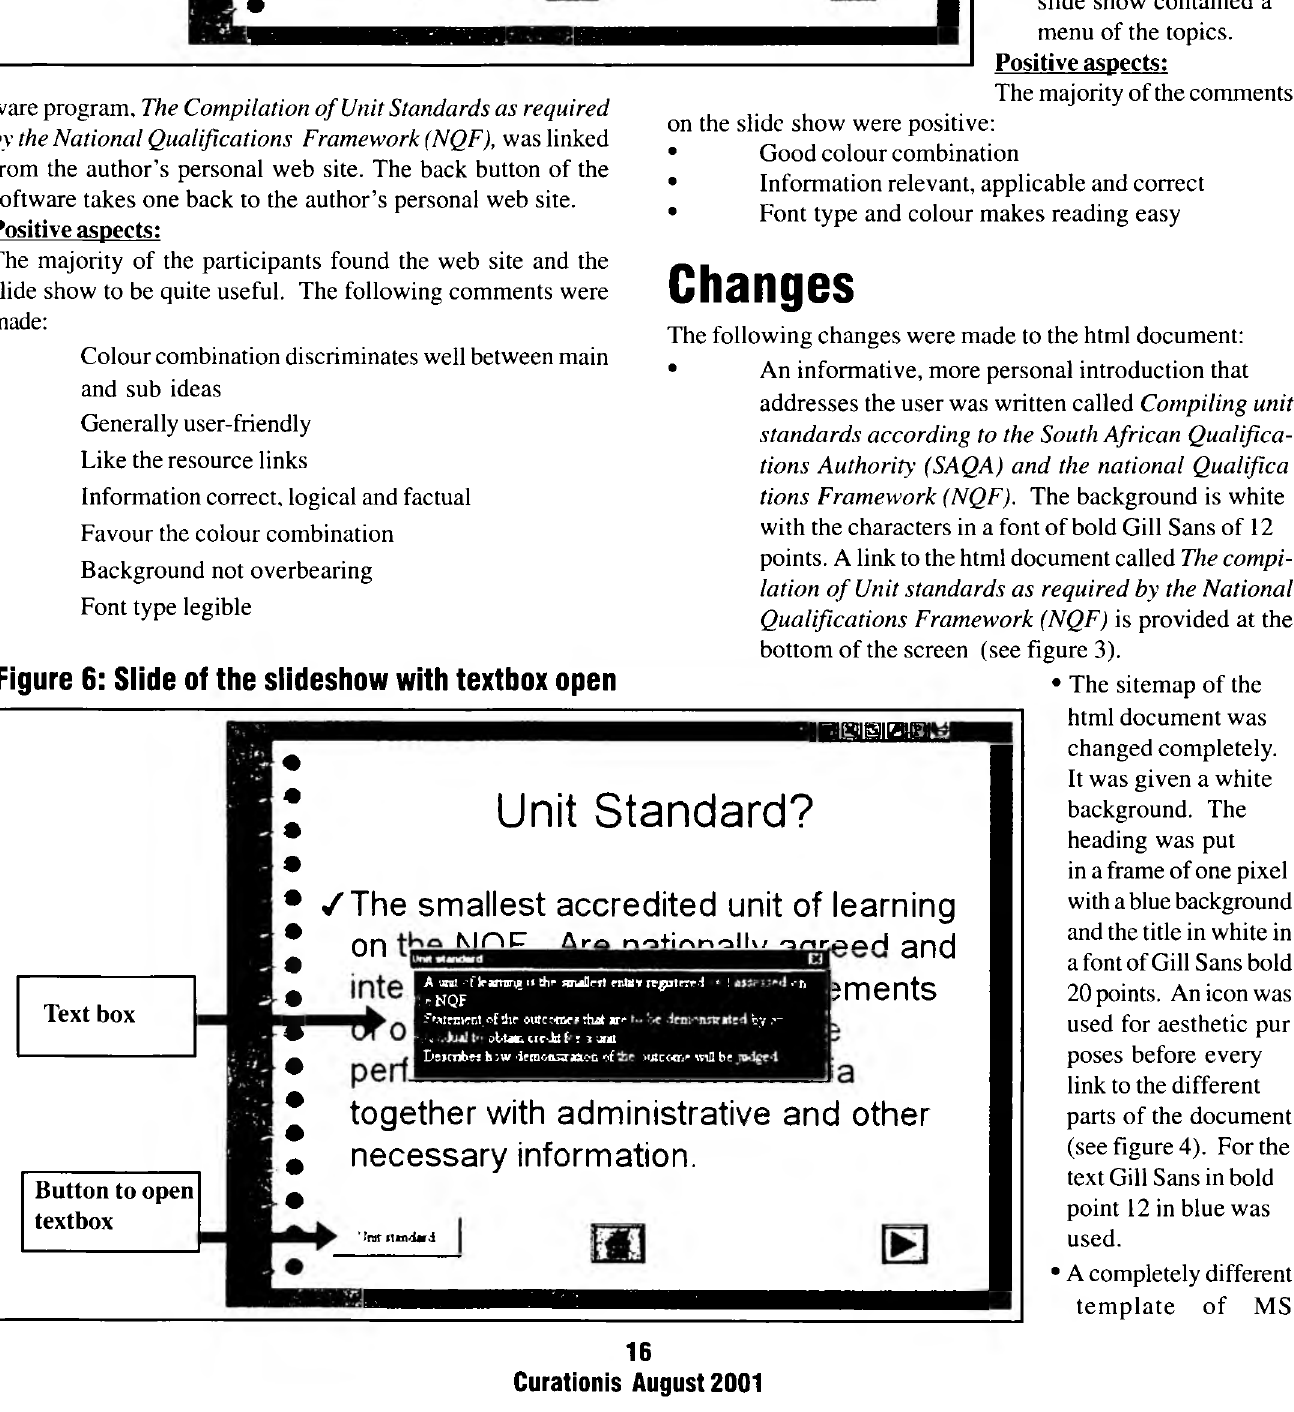
Figure 6: Slide of the slideshow with textbox